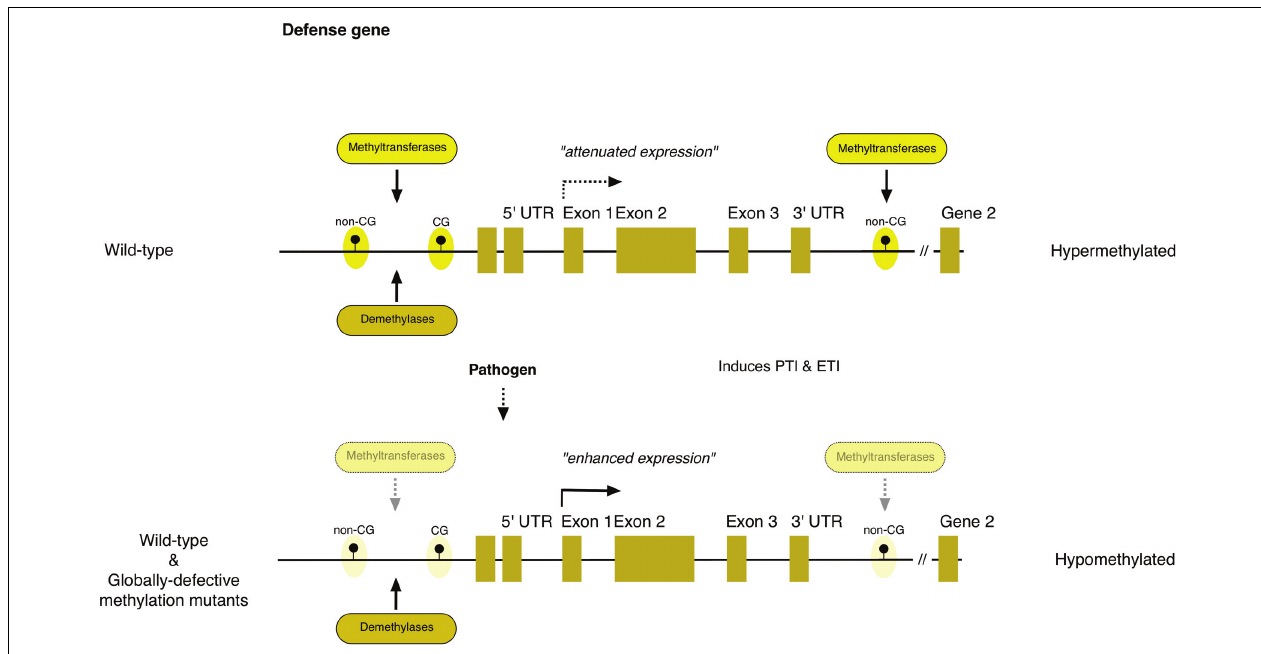
FIGURE 1 | A general model of epigenetic regulation of defense-related genes. Hypomethylation of regions flanking both ends of defense-related genes enhances their expression during pathogen challenges. Filled lollipops indicate transposable elements (TEs) or repetitive elements that may be methylated or